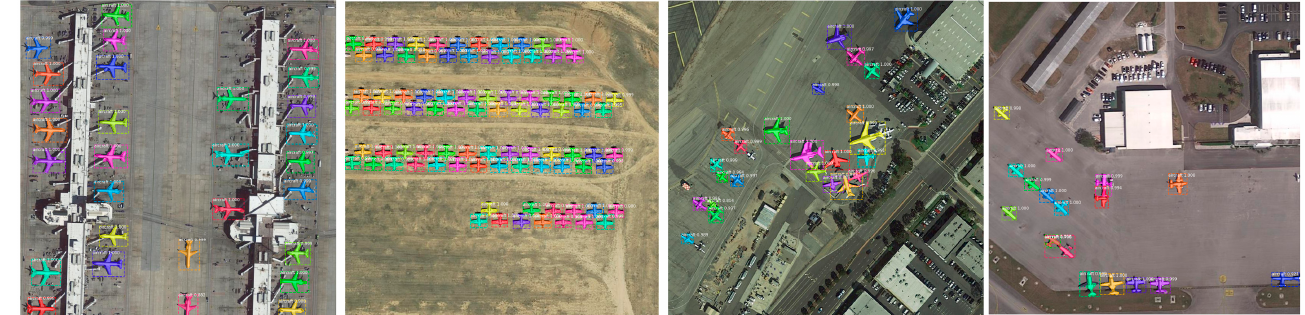
Figure 2. Detection and segmentation performance display in our proposed method.